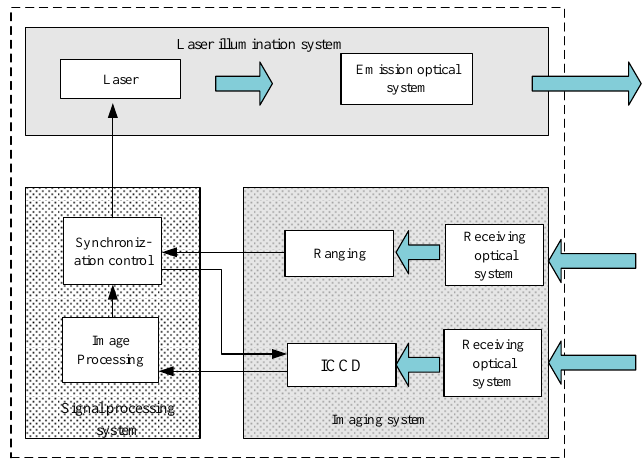
Figure 1. Schematic diagram of a typical gated imaging system.